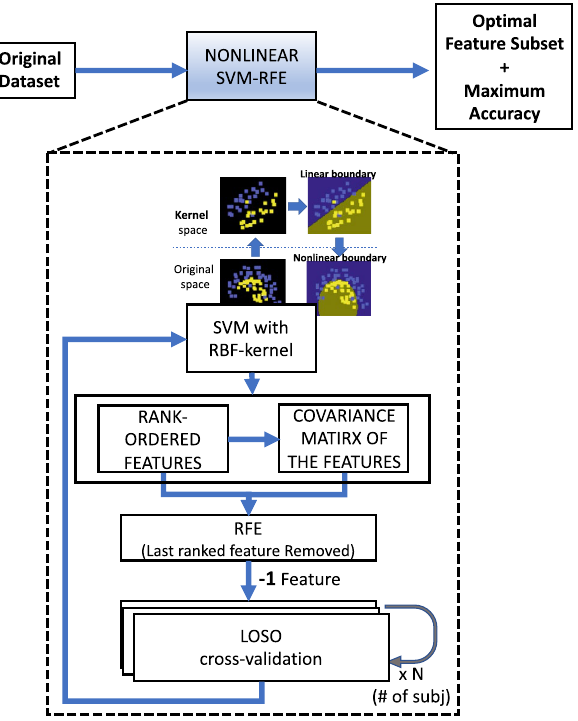
Figure 1. SVM-RFE with correlation bias reduction—conceptual